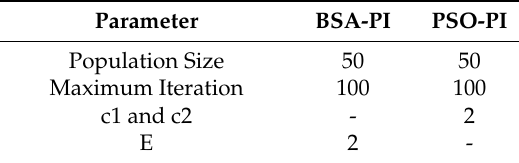
Table 5. Parameter settings of BSA-PI and PSO-PI.